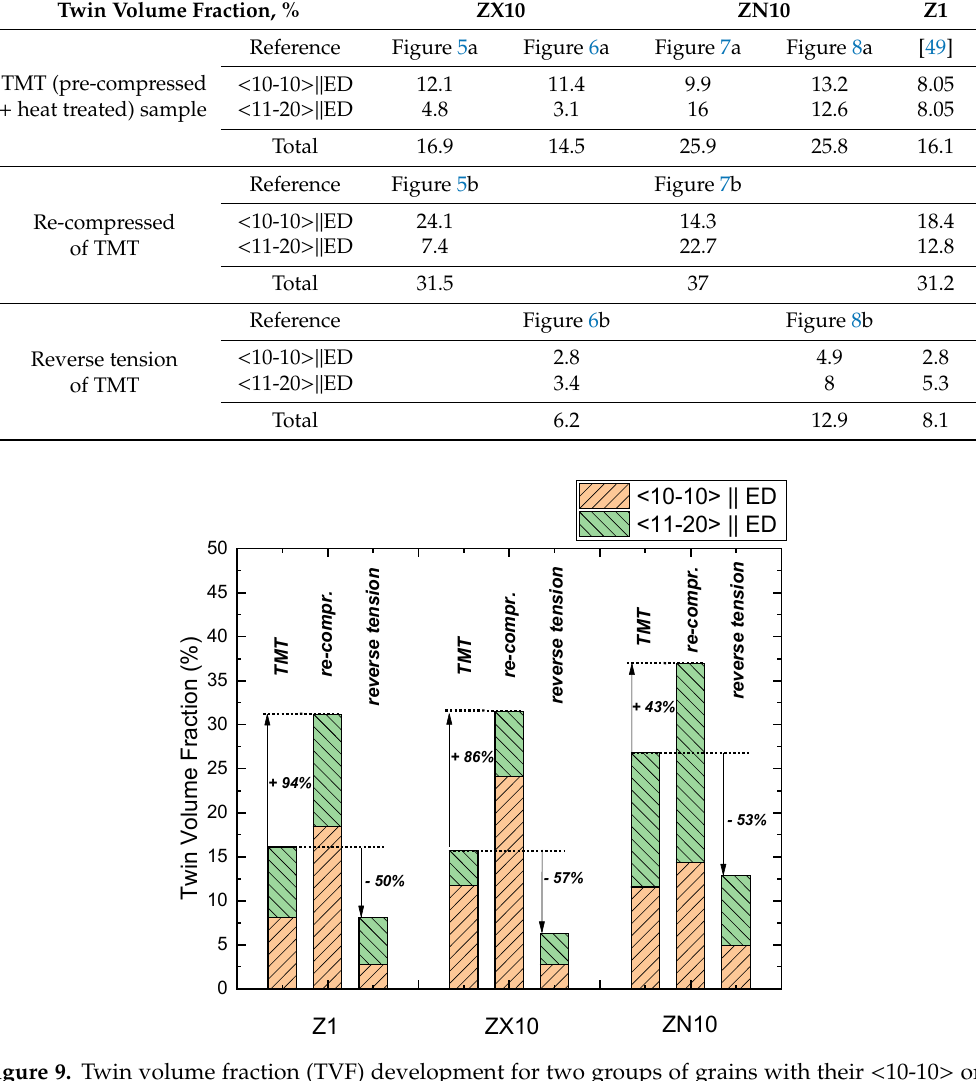
Figure 9. Twin volume fraction (TVF) development for two groups of grains with their <10-10> or <11-20> axis oriented parallel to the loading axis in the TMT state and subsequent loading of Z1 [49], ZX10 and ZN10 alloys. The evaluation error of TVF values for each sample is about 4%.